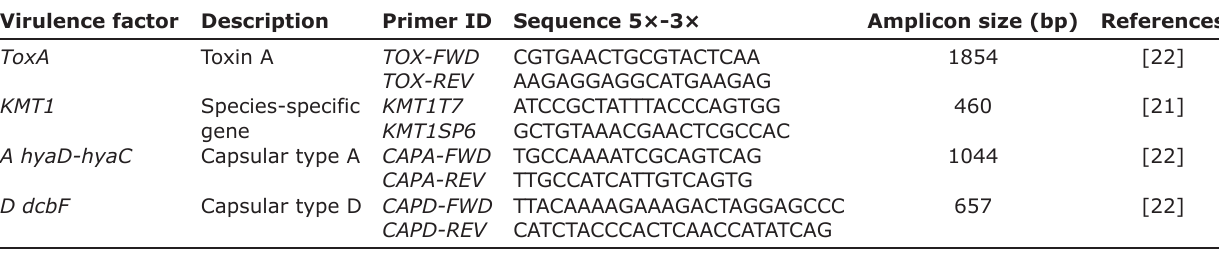
Table-1: Primers sequences of Pm virulence